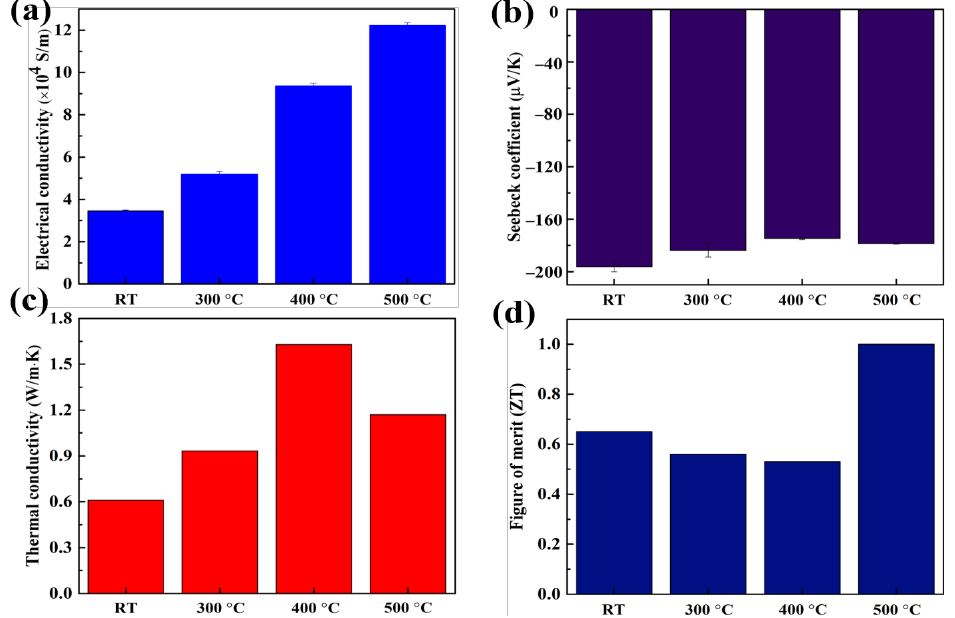
Figure 4. Measurement of thermoelectric properties at RT: ( a ) Electrical conductivity; ( b ) Seebeck coefficient; ( c ) thermal conductivity; and ( d ) ZT at RT, 300, 400, and 500 ◦